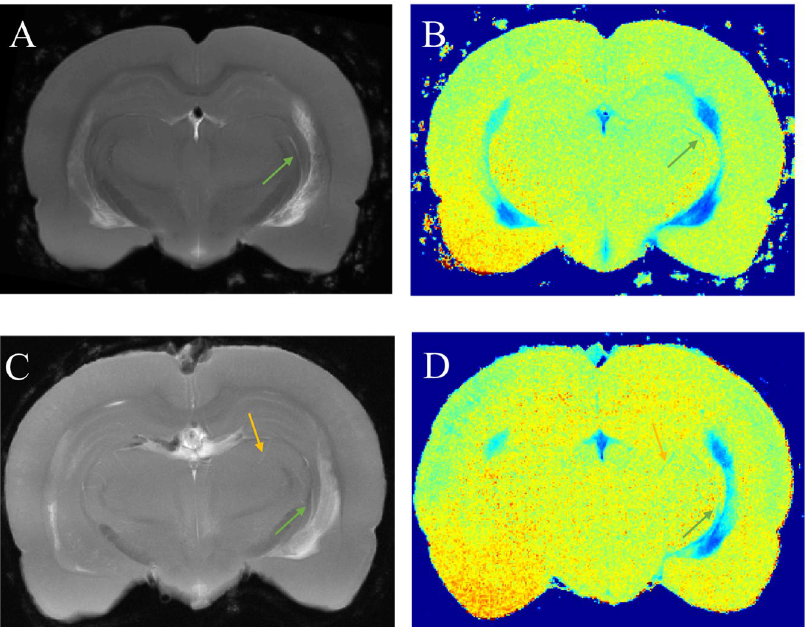
Figure 4. Co-localization of hyperintense perivascular spaces delineated in T 1 weighted images with reductions in T 1 . ( A , C ) High resolution T 1 weighted images from two rats used to reconstruct the perivascular network decimated in the slice direction by averaging to match the slice thickness of corresponding low resolution T 1 map which is shown in ( B , D ). Perivascular spaces surrounding internal carotid artery branch (green arrows) and penetrating thalamic blood vessel (yellow arrows) in T 1 weighted images and quantitative T 1 maps are marked for both the rats.